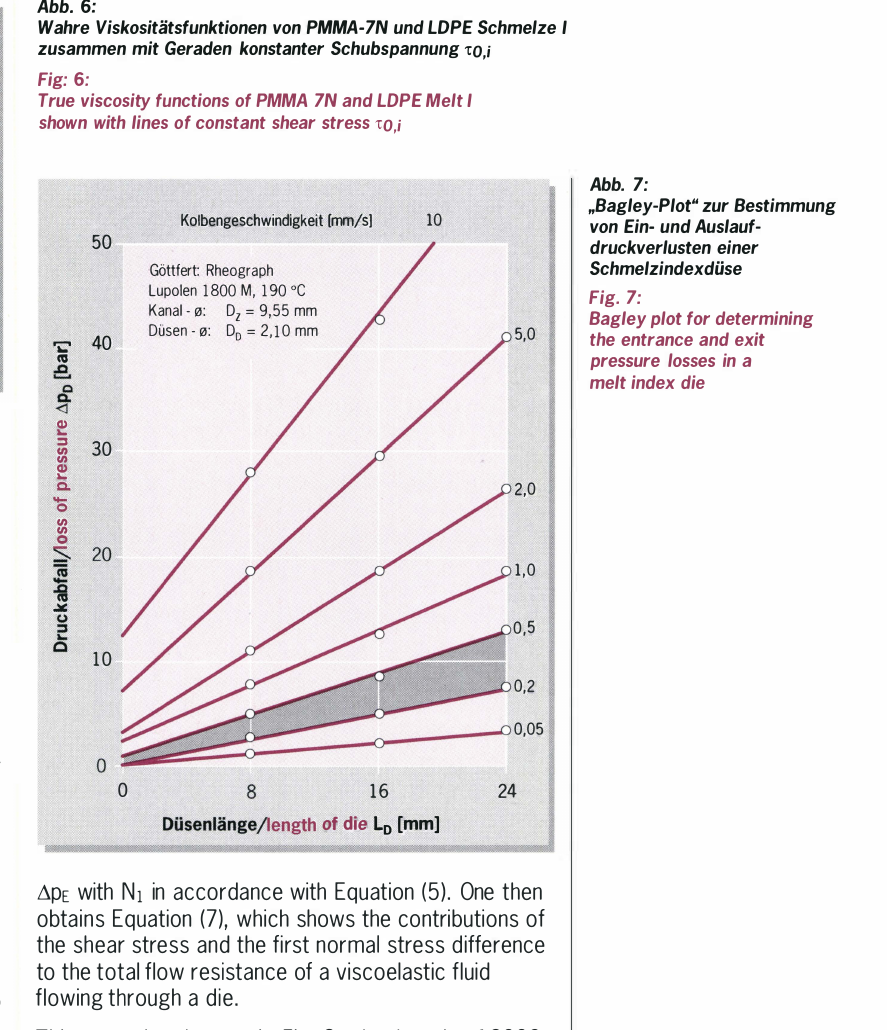
Table 1: Summary of the apparent and corrected flow data, obtained from measurements with the melt index tester. The corrected data includes the Rabinowitsch-WeiBenberg and Bagley corrections. LDPE Melt I measured at 150°C; Bagley correction calcul�ted with q =